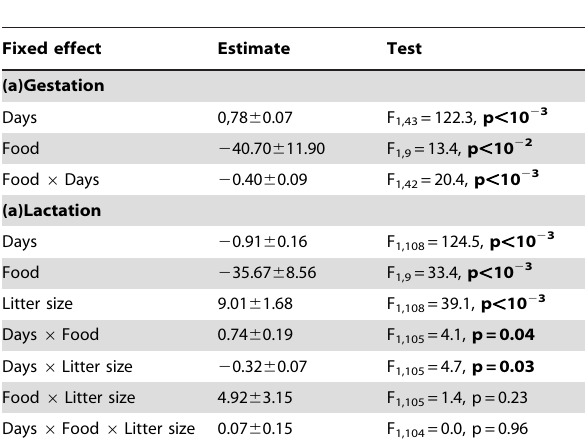
Table 3. Effects of food availability (Food effect: females fed ad libitum vs. females exposed to a chronic food restriction), time of gestation (Days effect; numbered from the day of copulation), and their interaction, on body mass of (a) gestating and (b) lactating females (N =11 females from Experiment